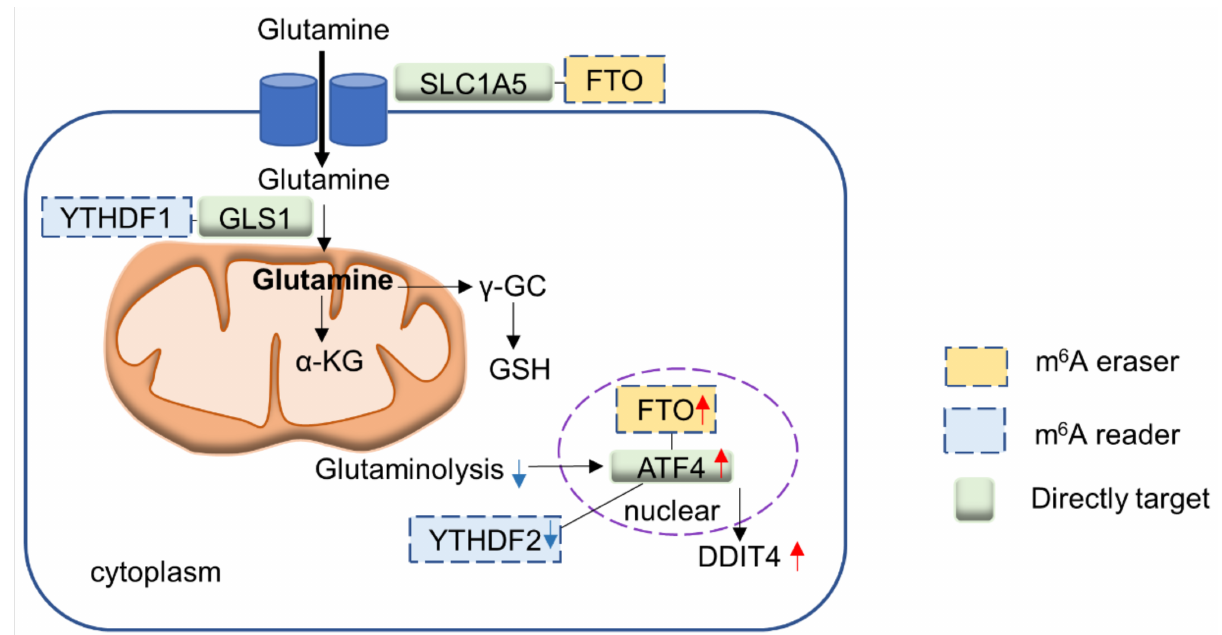
Figure 4. Schematic diagram summarizing the interplay between m 6 A regulators and amino acid